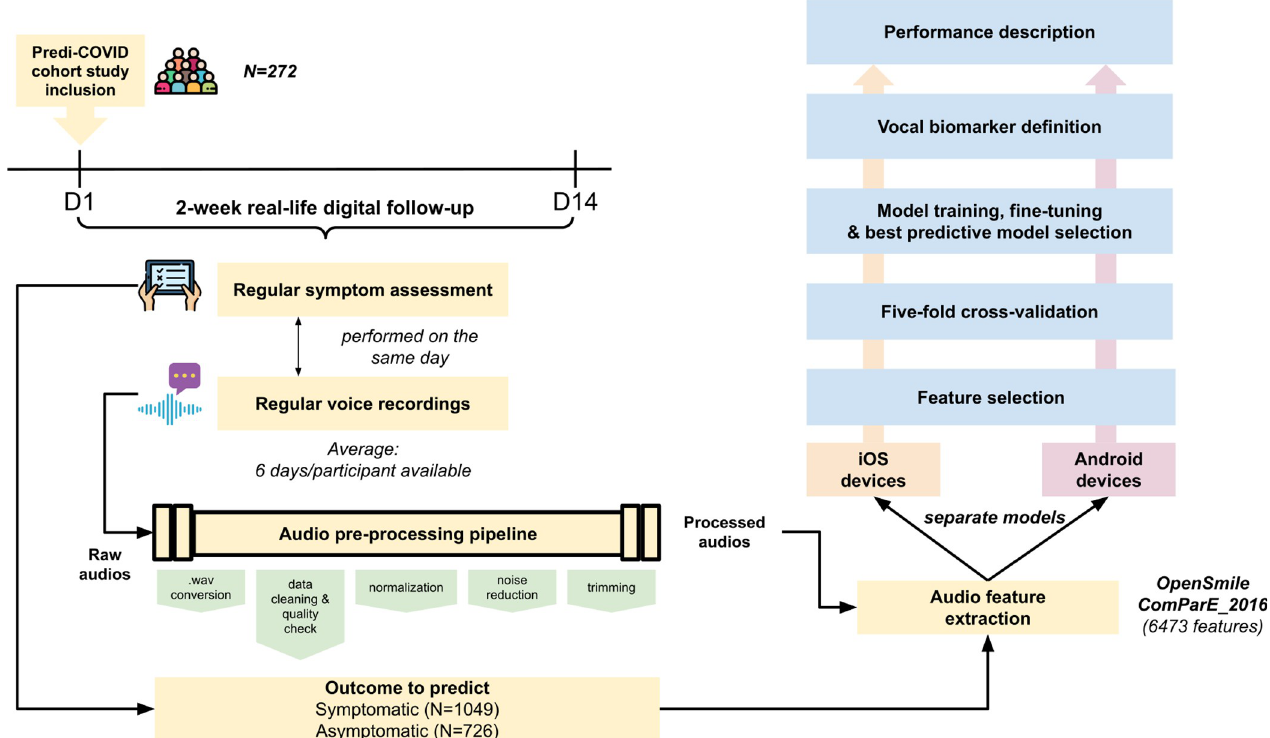
Fig 1. General pipeline from data collection to vocal